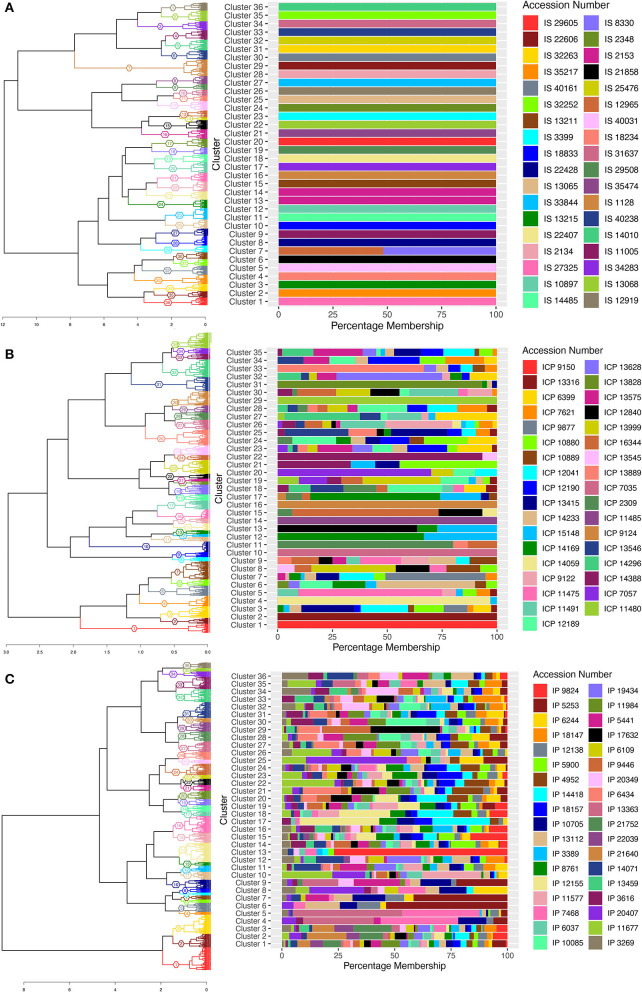
Cluster dendrogram of single plant phenotypic distances, using ward.D2 clustering algorithm, 36, 35, and 36 clusters for sorghum, pigeonpea, and pearl millet, respectively, represented with colors and cluster numbers, with percentage membership of accessions into each cluster denoted by colors in the adjacent bar graph. (A) the cluster dendrogram for sorghum, (B) the cluster dendrogram for pigeonpea, and (C) the cluster dendrogram for pearl millet.